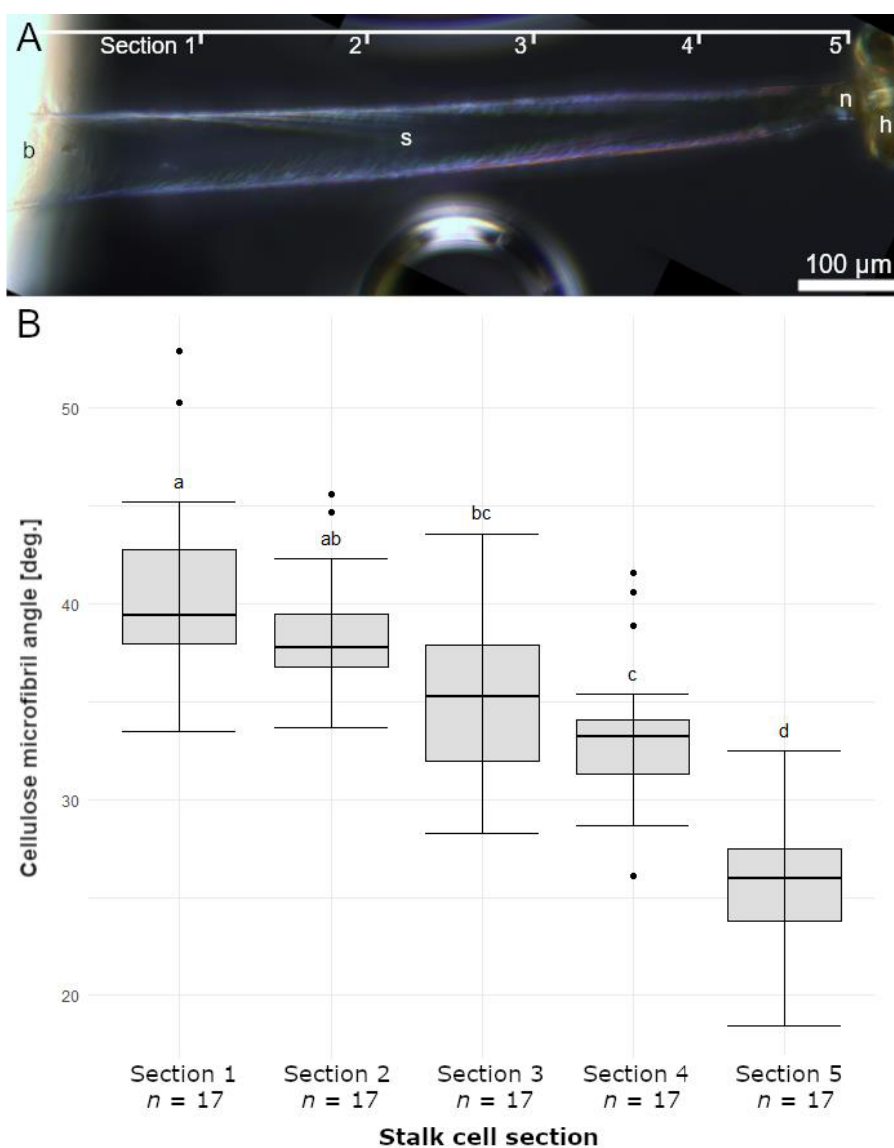
Figure 11. Cellulose microfibril angles in stalk cells. ( A ) Stalked gland divided into equally sized Sections 1—5. Section 1 represents the area at the base (b) of the stalk cell (s) near the trap leaf, whereas Section 5 is located directly below the head (h) and the neck cell (n). ( B ) The cellulose microfibril angles determined in relation to the long axis of each section are shown as boxplots. The cellulose microfibril angles become more acute from the base to the head of the stalked gland. The sample sizes ( n ) are indicated.